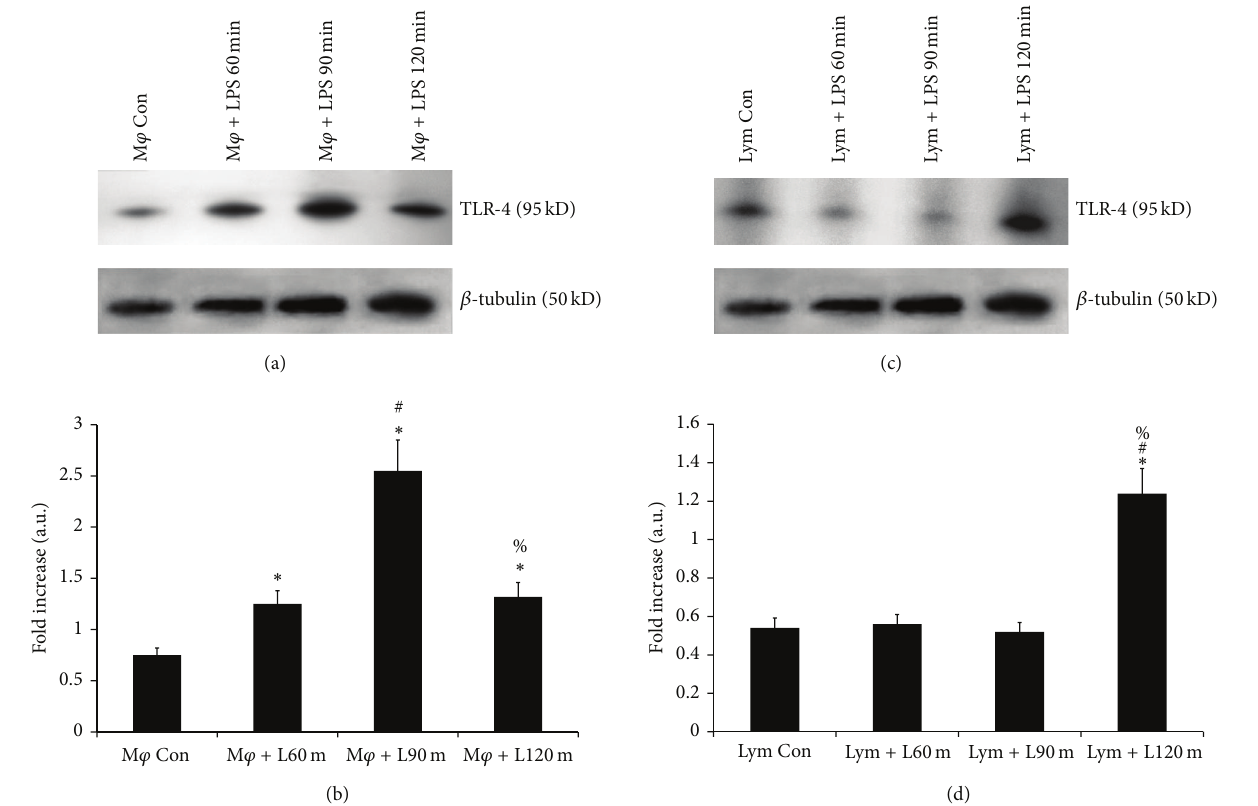
Figure 3: Expression of TLR-4 receptor in purified splenic macrophages and lymphocytes after in vitro stimulation with LPS. The results in (a) and (c) show the differential translation of the TLR-4 mRNA to the protein in the splenic macrophages and lymphocytes, respectively, after in vitro stimulation with LPS from a set of triplicate experiments. Lane 1 (M 𝜑 Con) represents TLR-4 on untreated macrophages, lane 2 (M 𝜑 + L60m) represents TLR-4 expression on the macrophages treated with LPS for 60 minutes, lane 3 (M 𝜑 + L90m) represents TLR-4 expression on macrophages treated with LPS for 90 minutes, and lane 4 (M 𝜑 + 120 m) represents TLR-4 expression on macrophages treated with LPS for 120 minutes. Lane 1 (Lym Con) represents TLR-4 on untreated lymphocyte, lane 2 (Lym + L60 m) represents TLR-4 expression on the lymphocyte treated with LPS for 60 minutes, lane 3 (Lym + L90 m) represents TLR-4 expression on lymphocyte treated with LPS for 90 minutes, and lane 4 (Lym + L120m) represents TLR-4 expression on lymphocyte treated with LPS for 120 minutes. The following symbols represent the significant fold change in TLR-4 expression between: ∗ control versus LPS treated cells, # LPS treatment for 60 min versus LPS treatment for 90 and 120 min, % LPS treatment for 90 min versus LPS treatment for 120 min. Significant change ( 𝑃 < 0.05